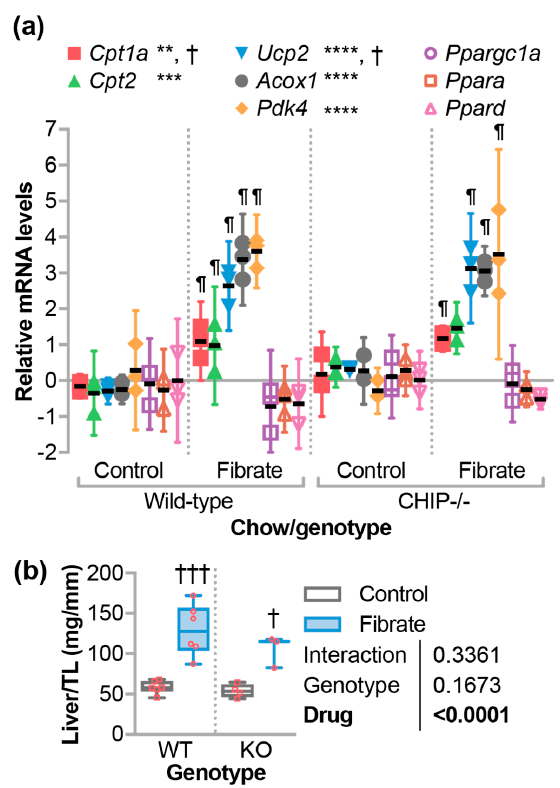
Figure 2. The effect of fenofibrate on liver. ( a ) Quantitative PCR analysis of gene expression in livers from either wild-type or CHIP − / − mice fed control or fenofibrate chow, which is represented by dot plot and summarized by the mean ± 95% CI, N = 3 animals per genotype per condition: **, ***, **** indicate p < 0.01, 0.001, 0.0001 or † p < 0.05 on the main effect of chow or genotype, respectively, via two-way ANOVA. indicates Tukey’s post-test < 0.05 in comparing fibrate to control conditions within genotypes. ( b ) Liver weight normalized to tibia length (TL) is represented by the boxplot with plotted biological replicates. Results of two-way ANOVA are provided, Tukey’s post-test: † and ††† indicate p < 0.05 and 0.001 comparing control vs. fibrate